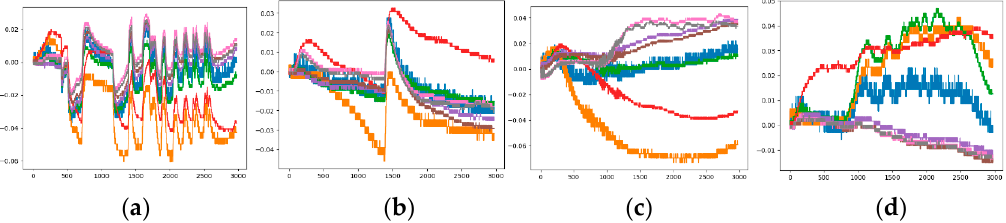
Figure 6. Unusual analogous-image ( a ) Low concentration of Methane; ( b ) Low concentration of Methane and Low concentration of Ethylene; ( c ) Low concentration of Methane and Medium concentration of Ethylene; ( d ) Low concentration of Methane.